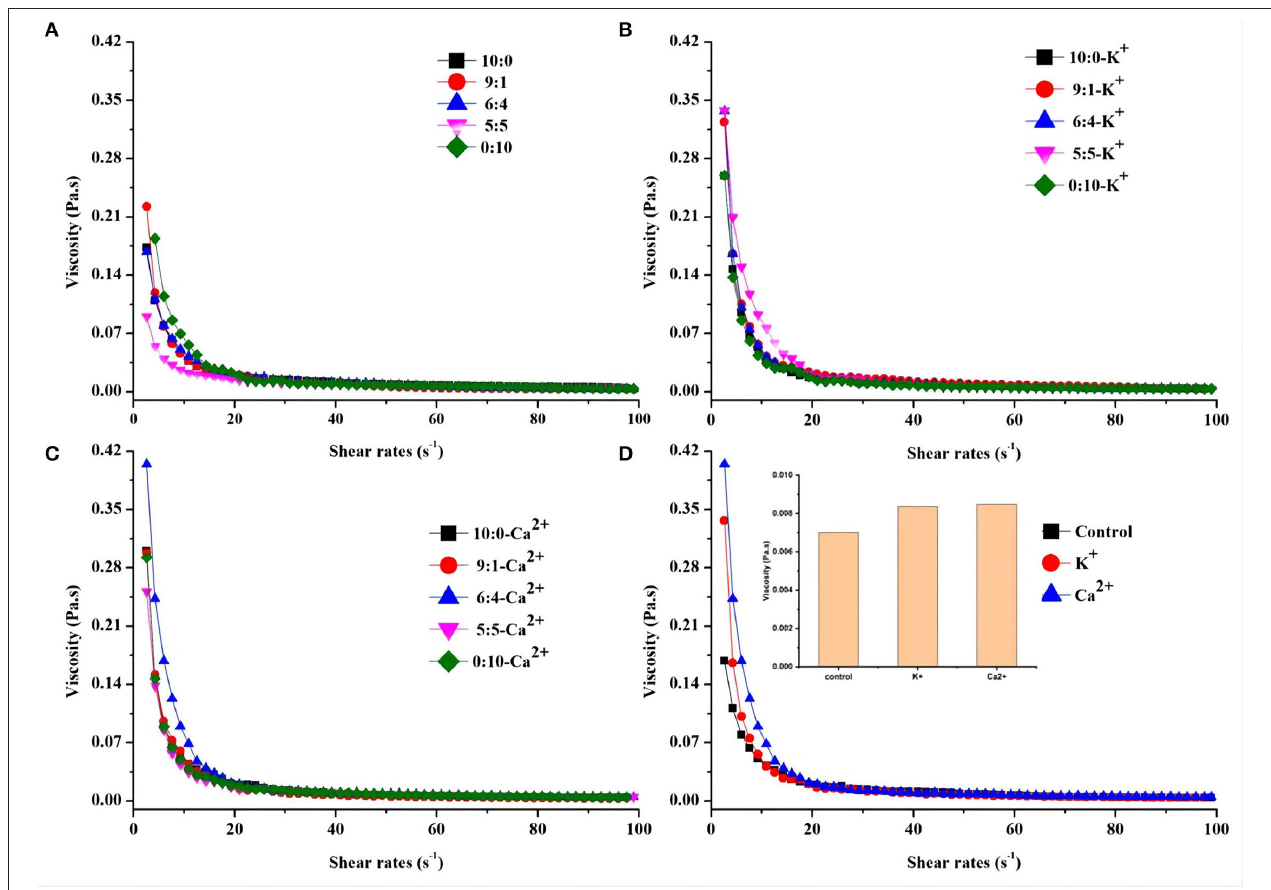
FIGURE 3 | Shear stress and viscosity relationships of OPO emulsions (10% v/v OPO human milk fat substitutes) at different protein ratios (WPI:CN/10:0, 9:1, 6:4, 5:5 and 0:10, 1% w/v in total; (A) either in the presence of K + (B) or Ca 2 + (C) . (D) Comparison of the shear stress and viscosity relationship of OPO emulsions for WPI:CN/6:4 (control) with K + or Ca 2 +